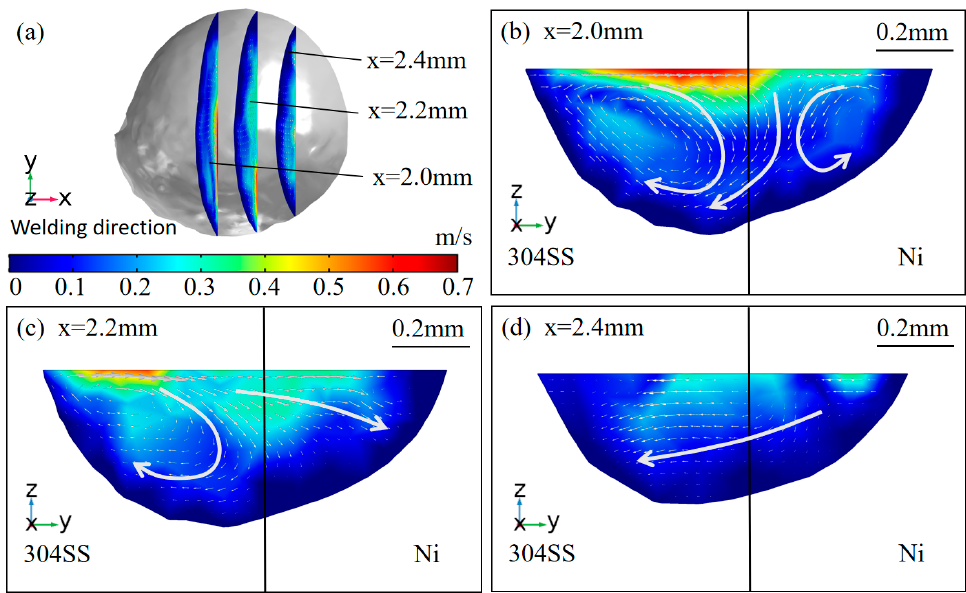
Figure 10. Fluid flow of the molten pool in the AMO for different Y–Z sections. ( a ) Overview of sections in the molten pool: ( b ) x = 2.0 mm; ( c ) x = 2.2 mm; ( d ) x = 2.4 mm.